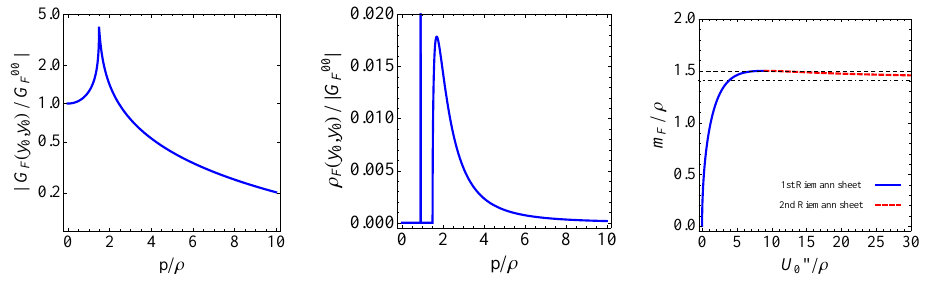
Figure 3. Plots of the Green’s function | G F ( y 0 ,y 0 ; p ) | (left panel), spectral function ρ F ( y 0 ,y 0 ; p ) (middle , in the LD model. To guide the eye, we display in panel), and dependence of the radion mass with U ′′ √ 0 the right panel horizontal lines for values m F = 2 ρ (dot-dashed black) and m F = m g (dashed black). = − 1 / (2 ρ ) . We ≡ lim In the first two panels we have normalized the functions by G 00 p → 0 G F ( y 0 ,y 0 ; p ) F = k (left panel) and U ′′ = ρ (middle have used A 1 = 23 , and U ′′ 0 0